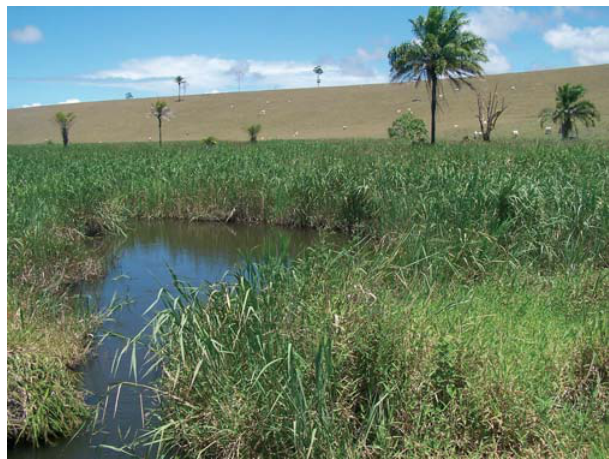
Fig. 8. Rio Palmares, a small stream, Prado, Bahia, northeast- ern Brazil, type locality of Ituglanis cahyensis